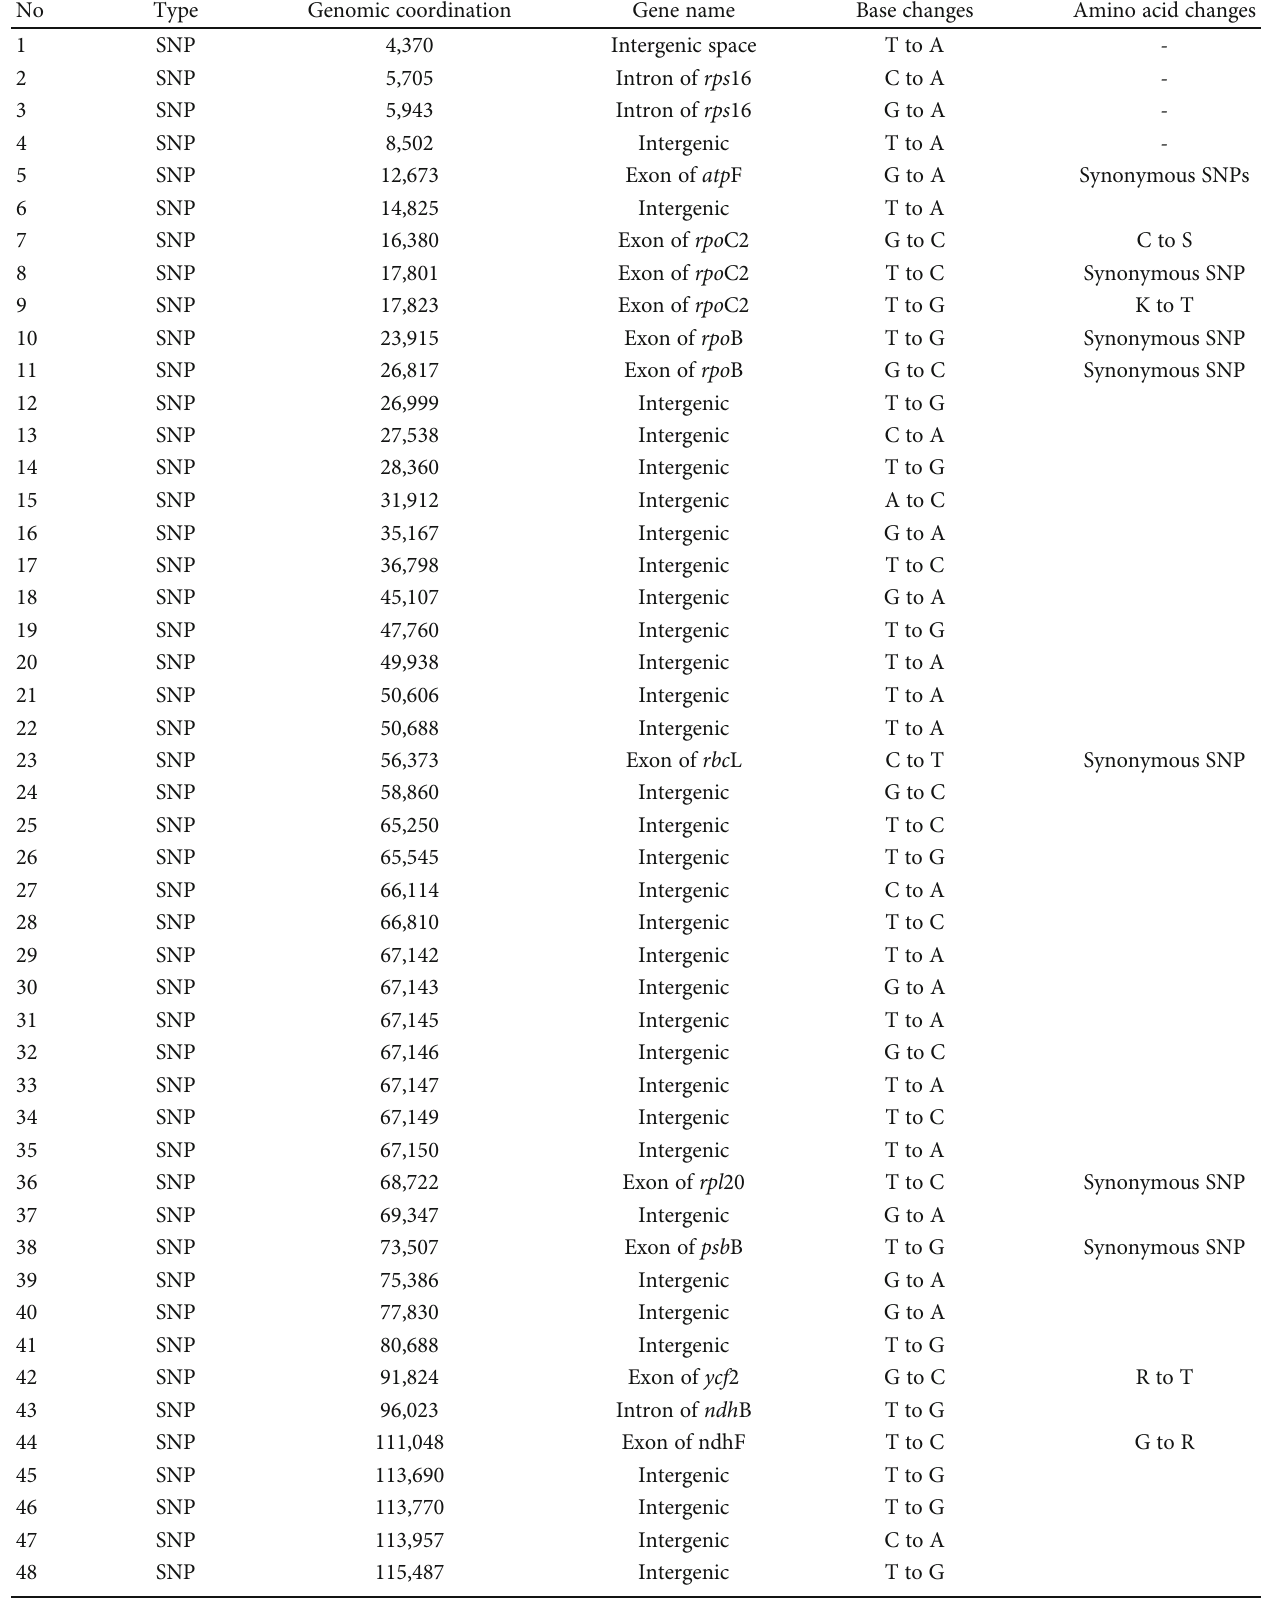
Table 2: List of genes containing SNPs and INDELs in 180404IB4 strain in A.